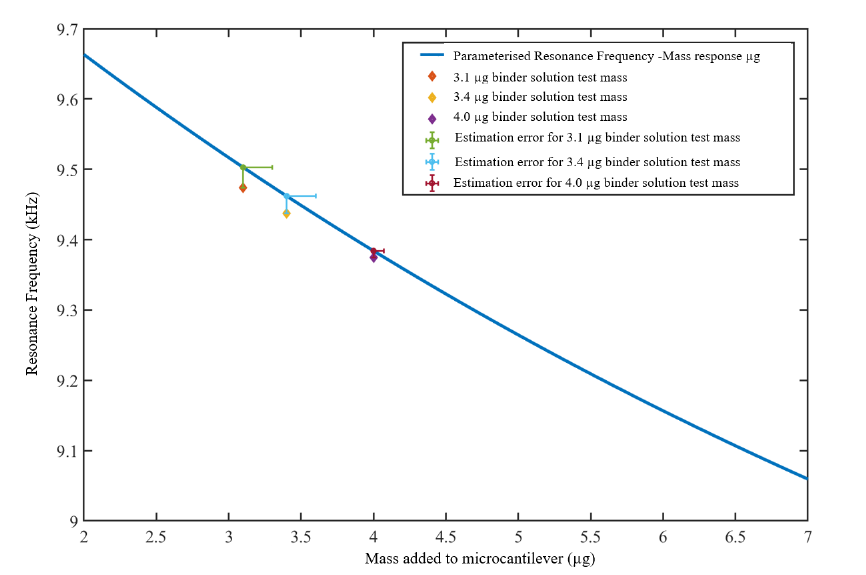
Figure 9. Estimation of the known test masses of the binder solution using the polynomial from calibration set-2.